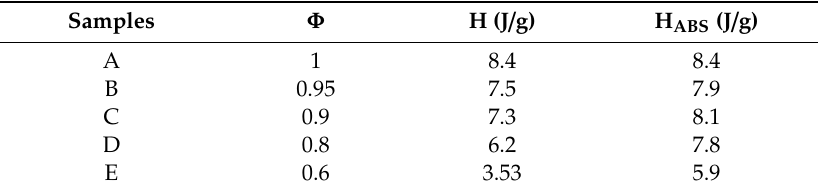
Table 2. Weight fraction ( Φ ) of ABS in the composite samples (A / E) and enthalpies of composites (H) and of ABS matrix (H ABS